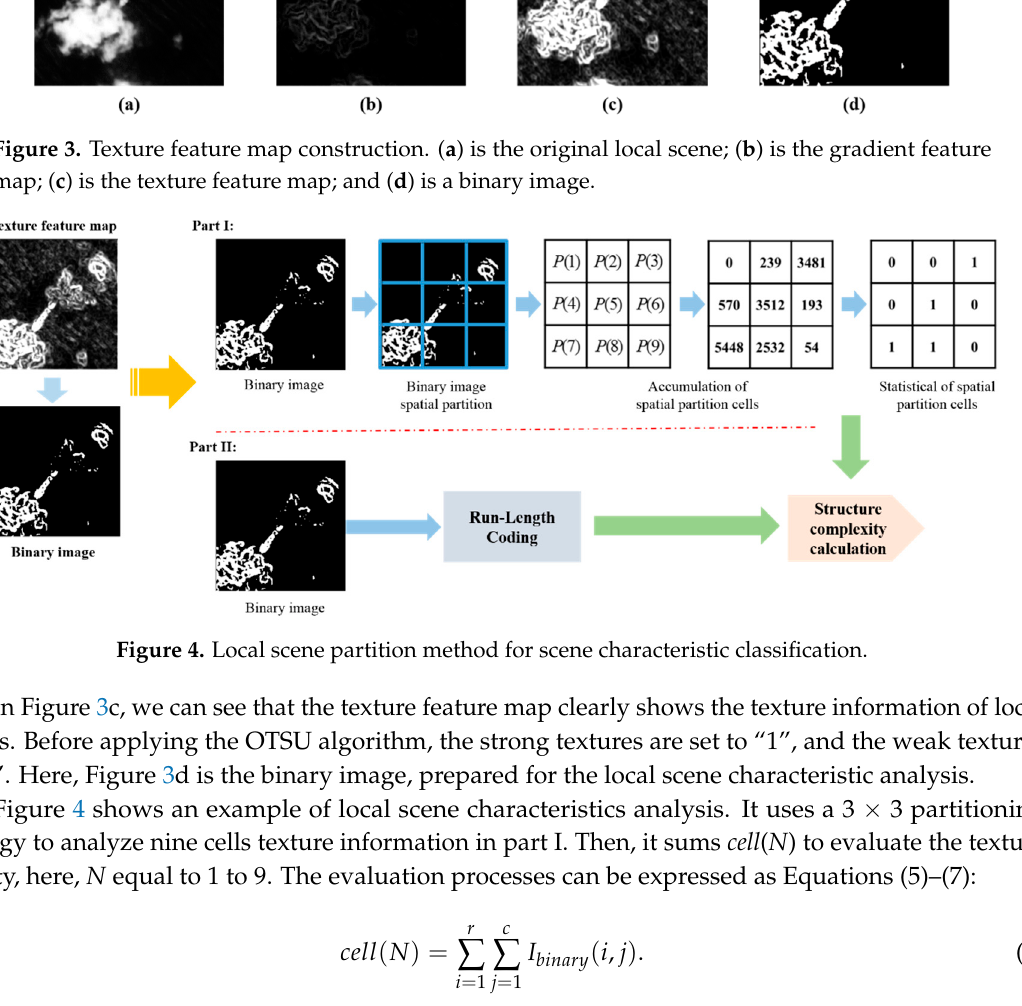
Figure 3. Texture feature map construction. ( a ) is the original local scene; ( b ) is the gradient feature map; ( c ) is the texture feature map; and ( d ) is a binary image.